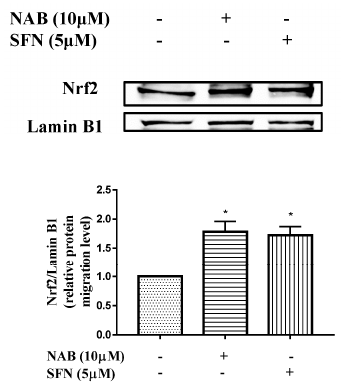
Figure 5. Effect of NAB on Nrf2 protein migration level in nucleoprotein of RAW264.7 macrophages. The RAW264.7 cells were treated with NAB or positive control drug (sulforaphane, SFN) for 6 h. The nuclear fraction was extracted, and the nuclear protein was measured by Western blotting. The density ratio of the CON group (normal control) was set to 1. Results are expressed as the mean ± SEM of three independent experiments. * P < 0.05 vs. normal cells.